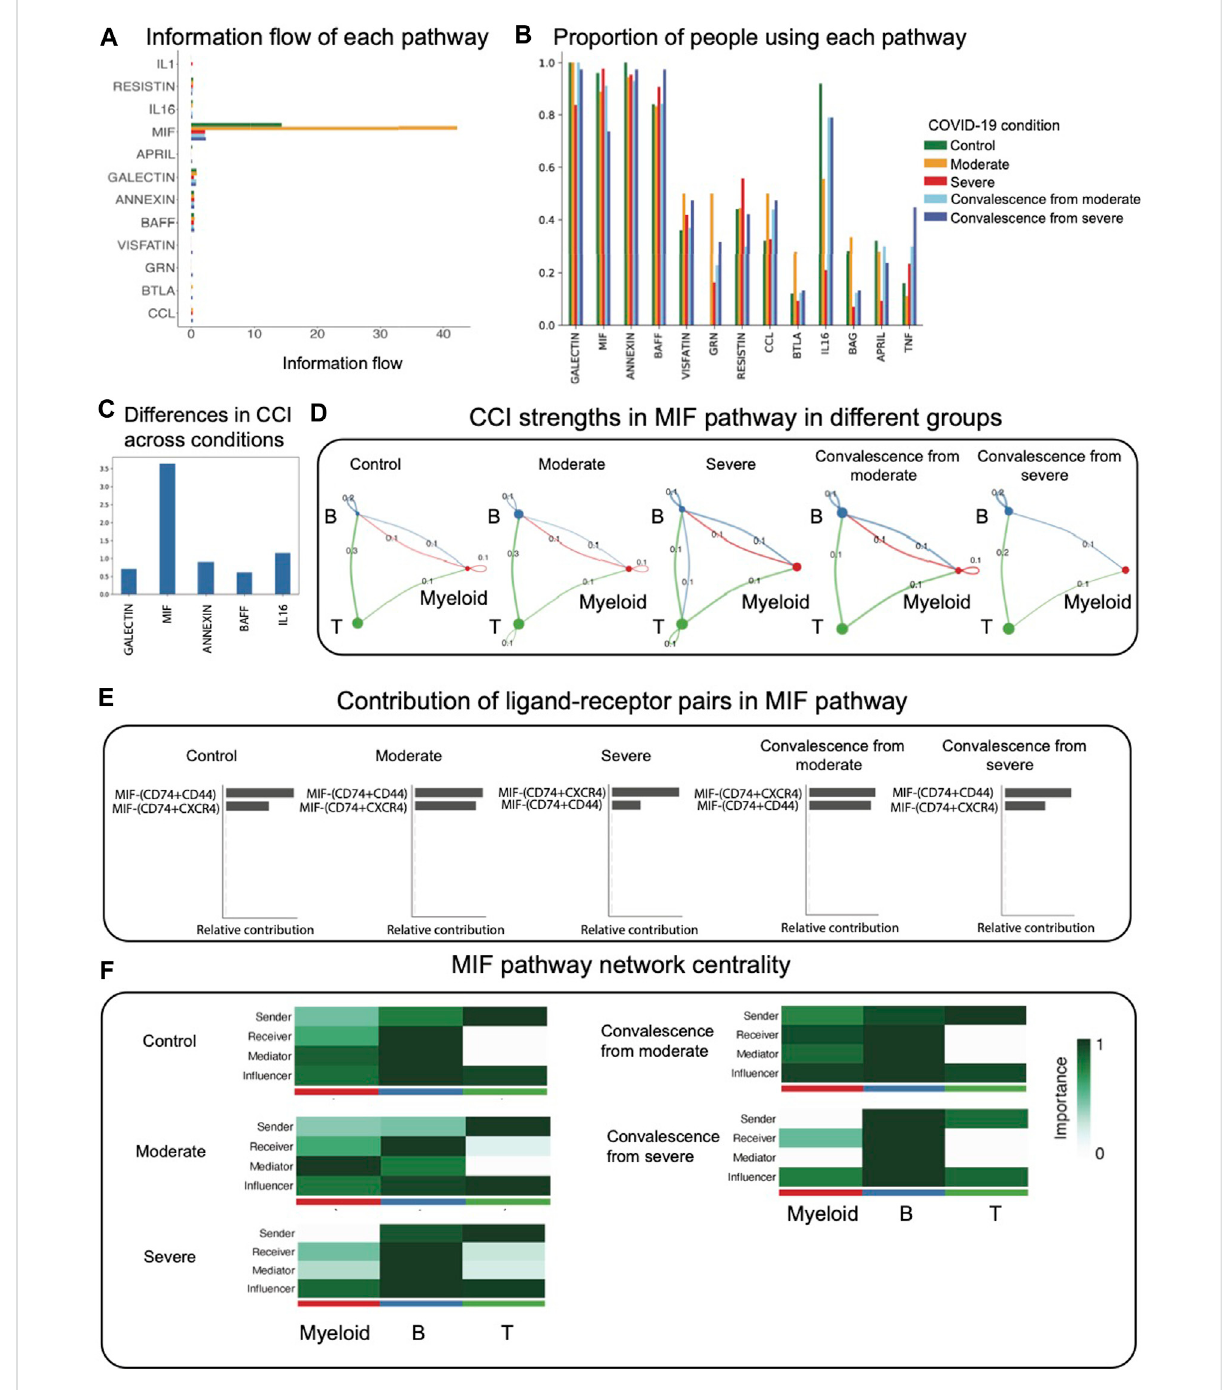
FIGURE 2 CCI analysis using CellChat focused on the MIF pathway. (A) Information fl ow (total interaction strengths) of each pathway. The MIF pathway contains the most amount of information. (B) Proportion of people using each pathway in different groups. The majority of CCI occurs through GALECTIN, MIF, ANNEXIN, and BAFF. (C) Average pairwise Canberra distance of CCI across conditions in the popular pathways. (D) . CCI strengths in the MIF pathway. Each edge represents an interaction; the color of the edge matches with the sending cell type. (E) Relative contribution of ligand – receptor pairs in the MIF pathway. (F) Network centrality scores of the MIF pathway. In severe and convalescence from severe groups, myeloid cells lose its function as a